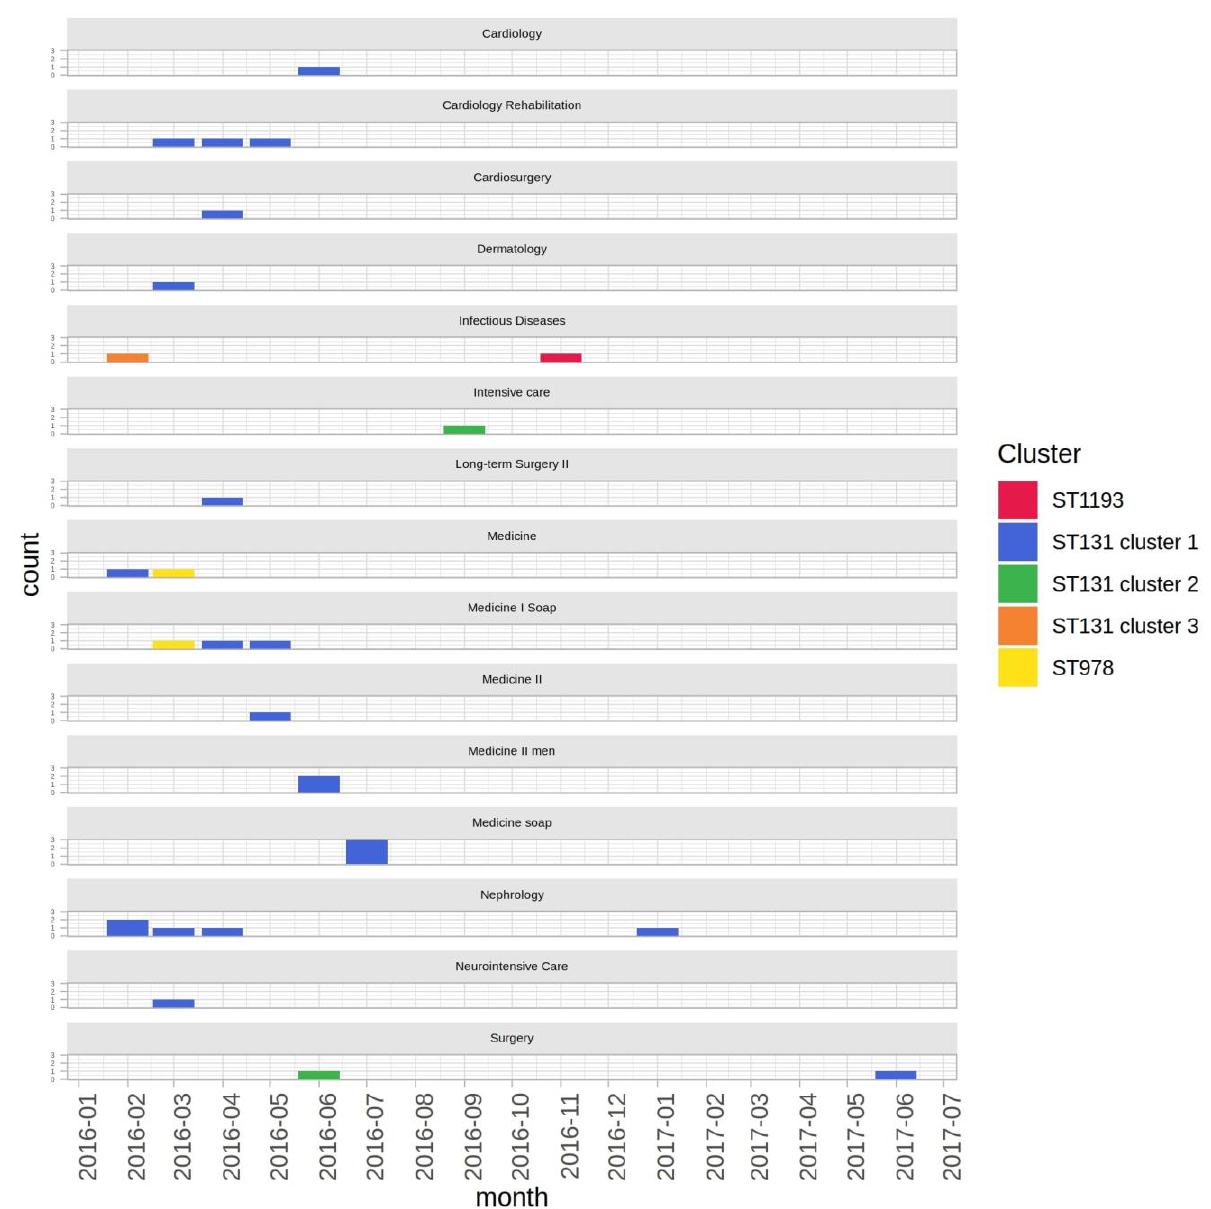
Figure 2. Barplot of the number of isolates per month per ward. Bars were colored on the basis of the phylogenetic clusters shown in Figure 1.